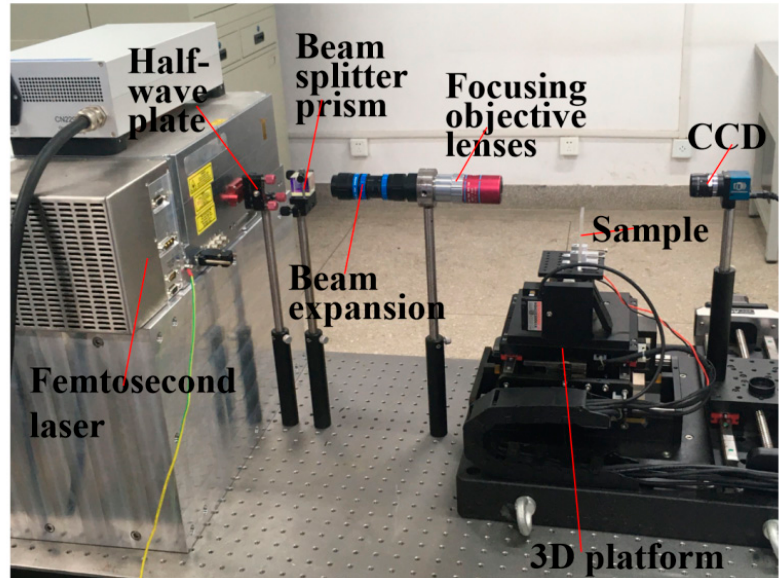
Figure 1. Stereogram of femtosecond laser 3D micromachining system.